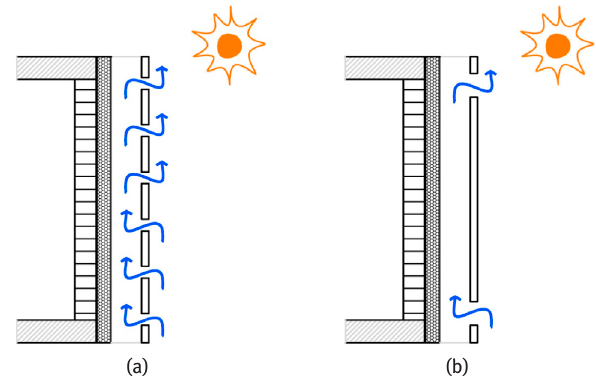
Figure 3: Types of ventilated facades: (a) open joint and (b) closed joint